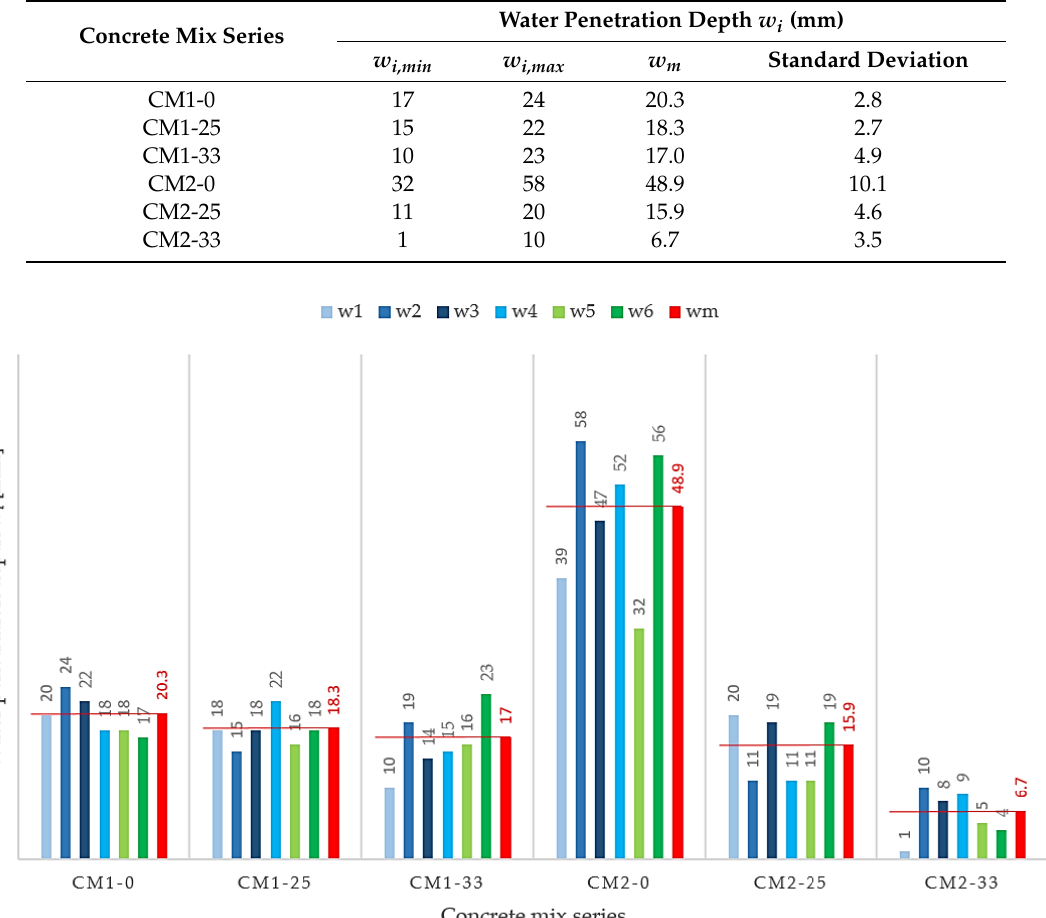
Table 7. Summary of the results of testing the depth of penetration of water under pressure into concrete.